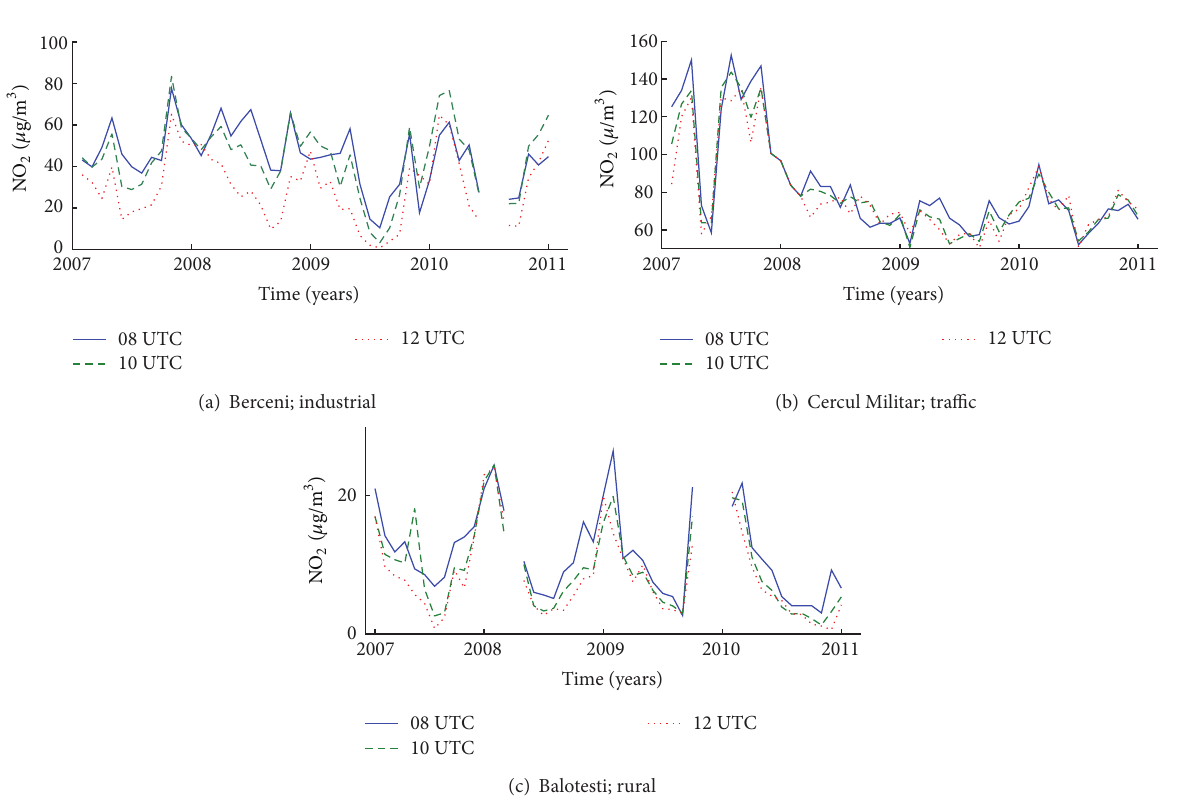
Figure 6: Daily variation of NO 2 in three locations with different types of NO 2 sources: industrial (power plant), urban (mainly traffic), and rural (no important